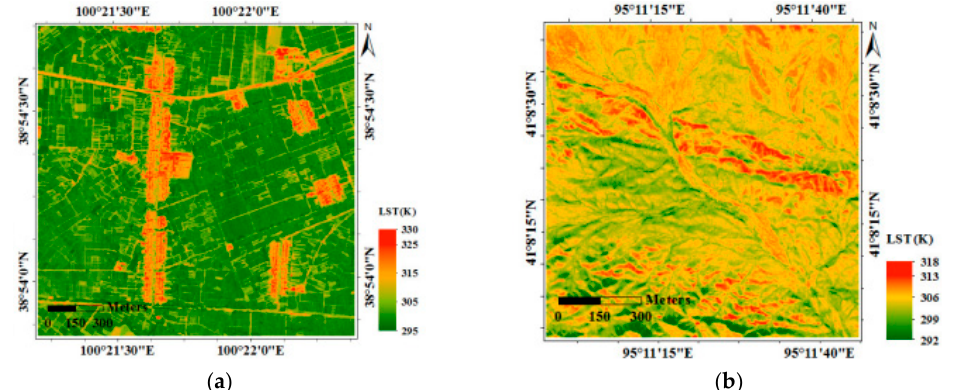
Figure 2. Land surface temperature retrieval from GF-5 simulation images in two sites. ( a ) YingKe site; ( b ) Liuyuan site [53].